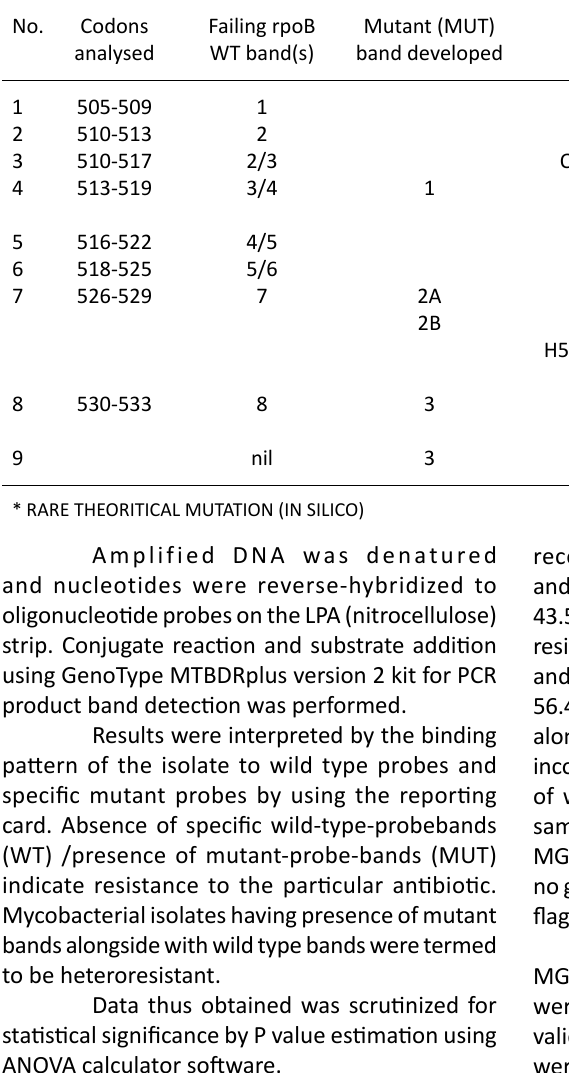
table 1. rpoB gene patterns detected by GenoType MTBDR plus assay No. Codons Failing rpoB Mutant